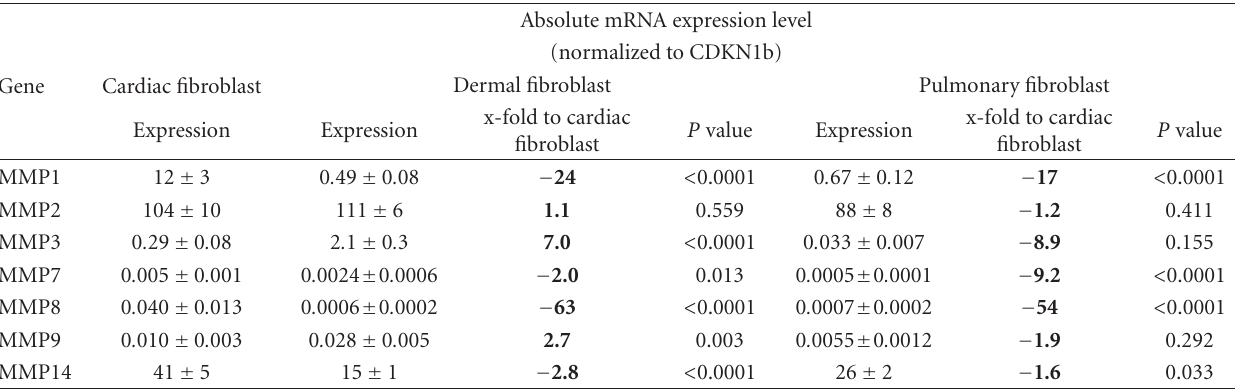
Table 1: Absolute mRNA expression levels of di ff erent MMPs in cardiac, dermal, and pulmonary human fibroblasts. The mRNA expression was normalized to the housekeeping gene CDKN1b using the formula 2 − Δ Ct . For statistical significance dermal or pulmonary expression was compared to the expression in cardiac fibroblasts using Mann-Whitney U test.